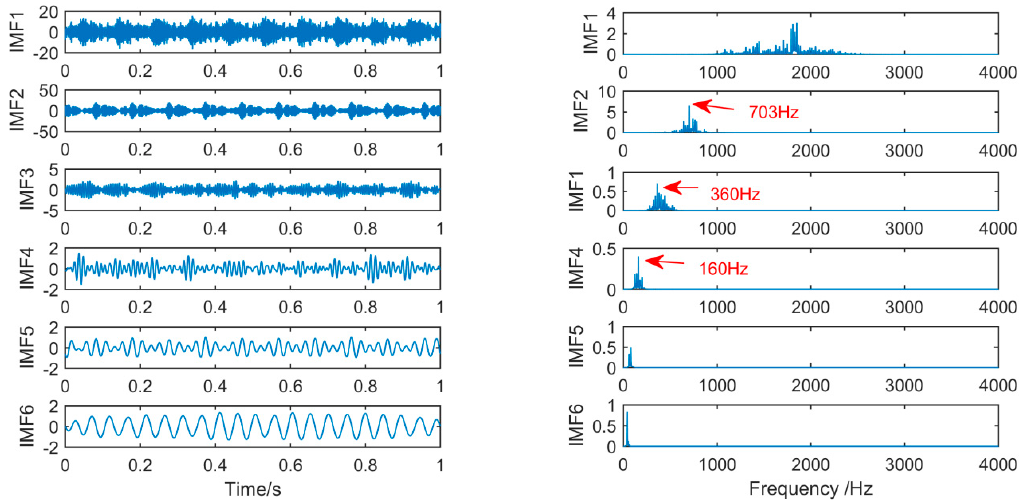
Figure 17. The spectrum of IMFs after SSD decomposition and its corresponding spectrum.